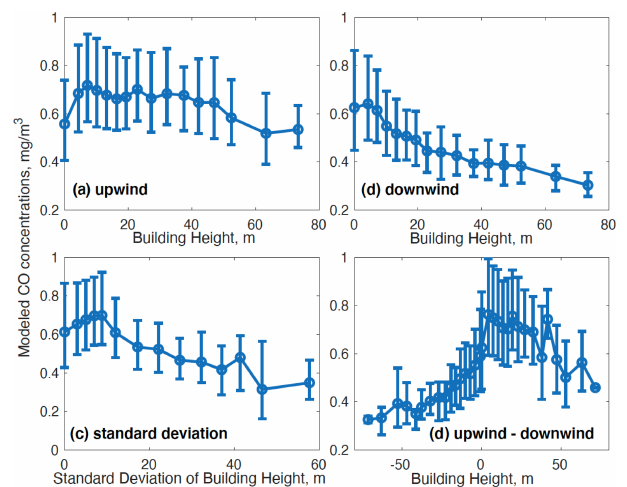
Figure 12. Relationship between geometric mean modeled ground- level CO concentrations and building heights in the upwind (a) and downwind (b) directions, (c) the standard deviations of nearby (within 50m distance) building heights, and (d) the difference be- tween the upwind and downwind building heights. Wind speed is assumed to be 6.5ms − 1 , and emissions are specified as that during rush hours.